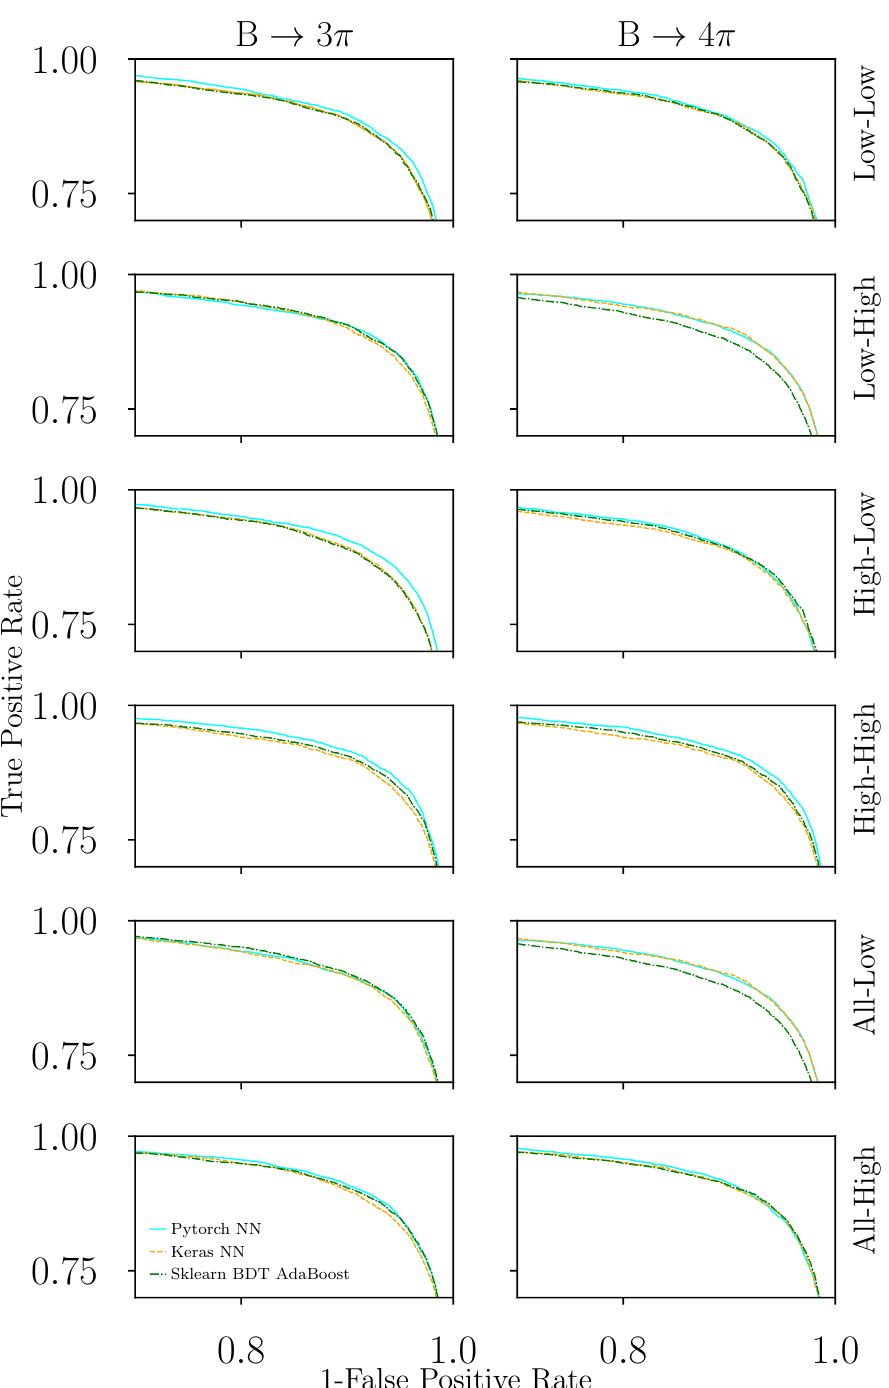
Figure 7. ROC Curve for the B The options are those listed in Section